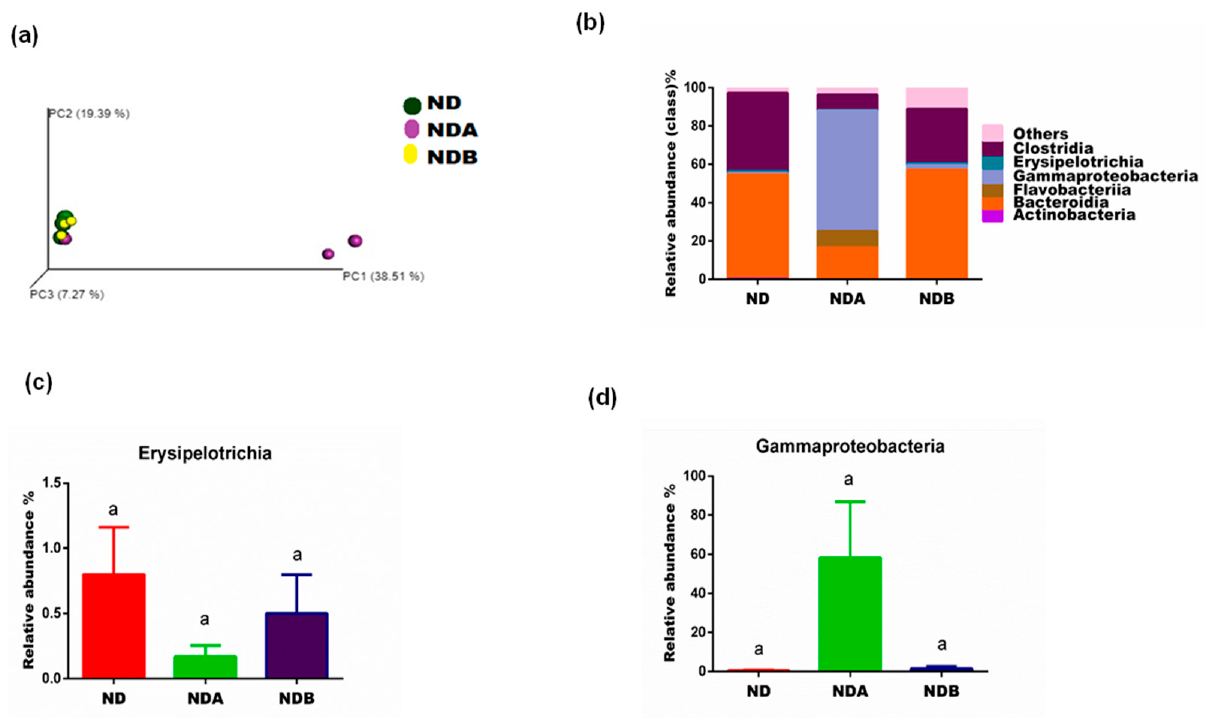
Figure 4. Effects of urolithins on the structure and composition of the gut microbiota. Principal coordinate analysis ( a ), relative abundance at the class level ( b ), relative levels of Erysipelotrichia ( c ), relative levels of Gamma-proteobacteria ( d ). a Data are expressed as mean ± SE. Mean values bearing different letters are significantly different ( p < 0.05).